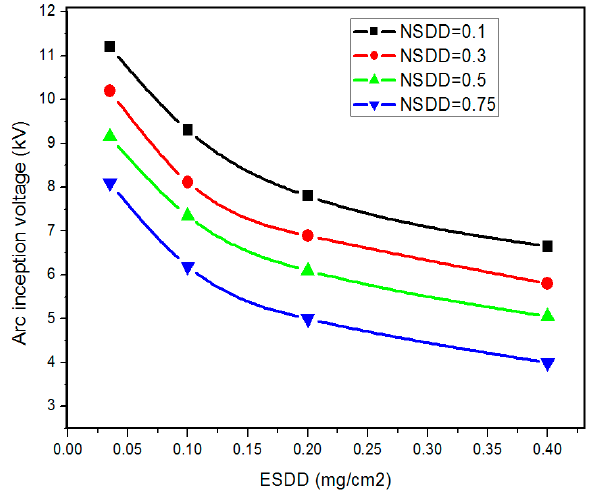
Figure 6. Arc inception voltage at different non-soluble salt deposit density levels, where pollution distribution = uniform, humidity level = low, temperature = 10 °C, and standard deviation = 3.2%–5.8%.